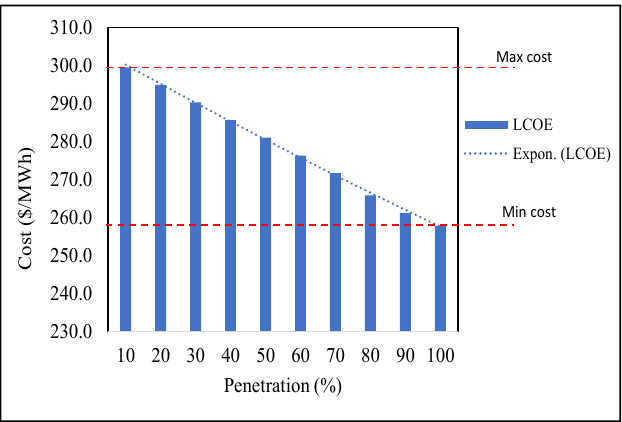
Figure 16. Relationship of PV penetration (%) to LCOE. Table 5. PV system short circuit